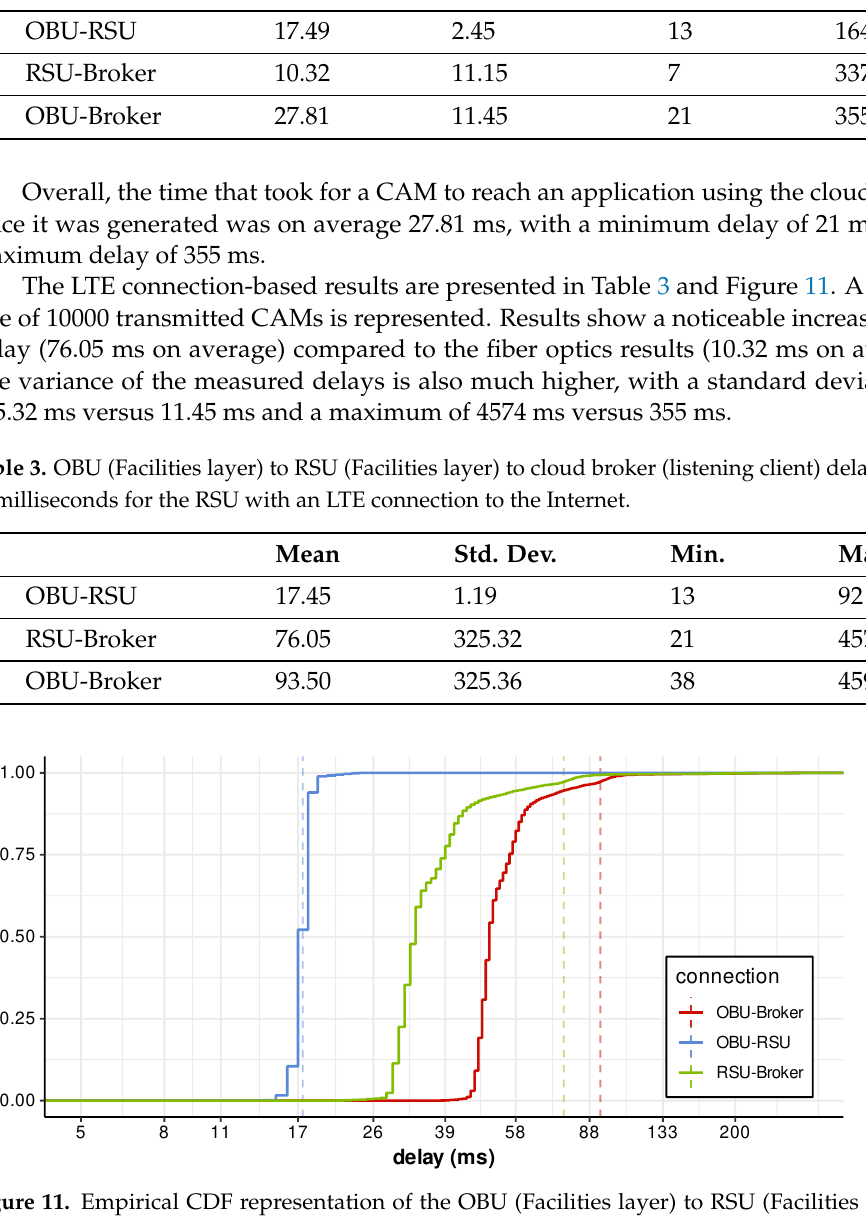
Table 2. OBU (Facilities layer) to RSU (Facilities layer) to cloud broker (listening client) delay results in milliseconds for with the RSU with a fiber optics connection to the Internet. Std. Dev.